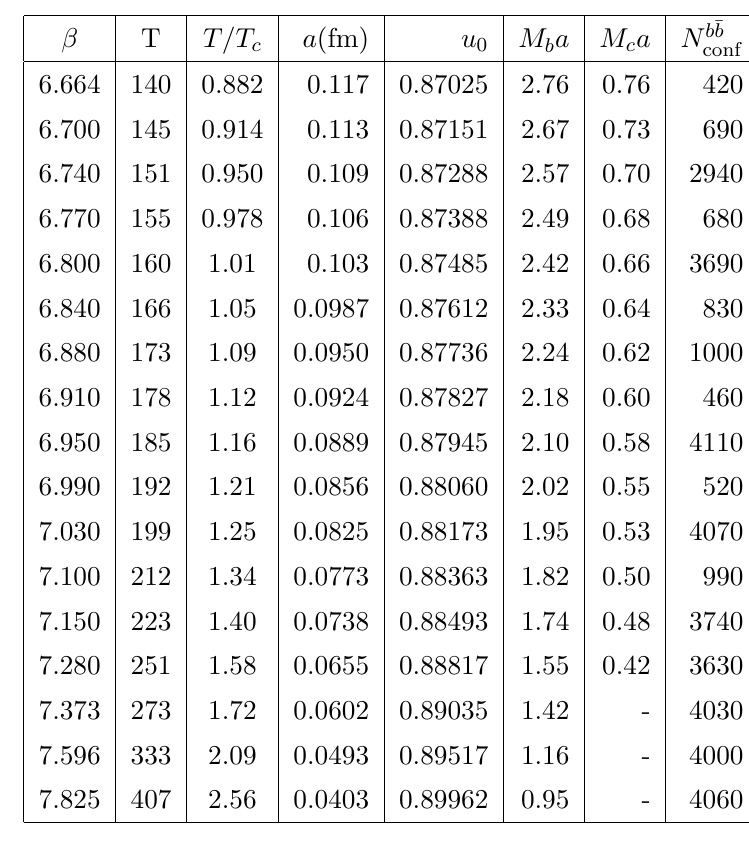
Table 2 . Parameters of the HISQ lattice con(cid:12)gurations at T > 0 with size 48 3 (cid:2) 12, which underlie the extraction of the in-medium spectral functions. For charmonium we have a evaluated the correlators on N c (cid:22) c = 400 con(cid:12)gurations conf